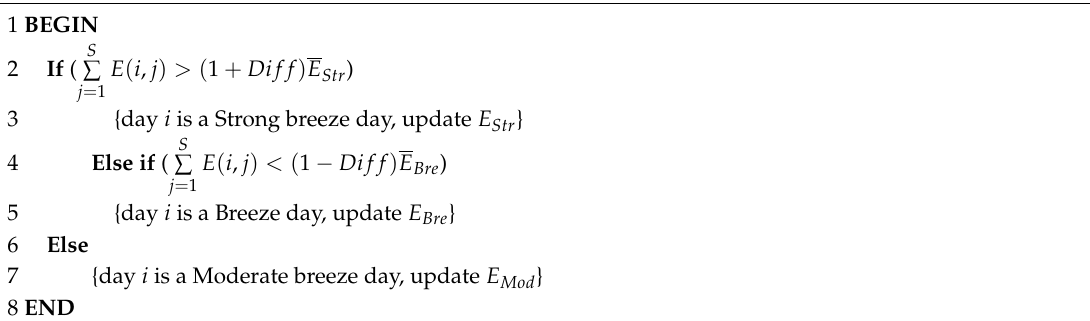
Algorithm 3 Harvested energy classification algorithm for different weather